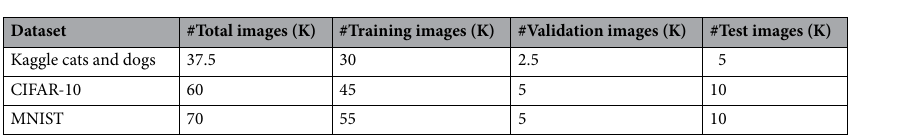
Table 1. Number of images for network training, validation and test.